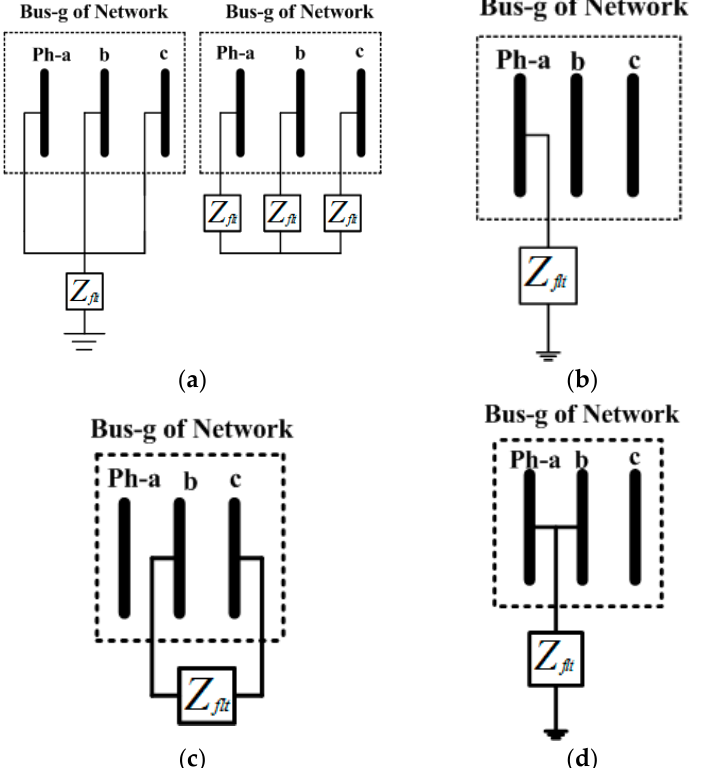
Figure 2. Occurrence of faults at bus g named as ( a ) Symmetrical fault; ( b ) Single line to ground fault at phase-a; ( c ) Line-to-line fault at phase-b and phase-c; ( d ) Double line to ground fault at phase-a and